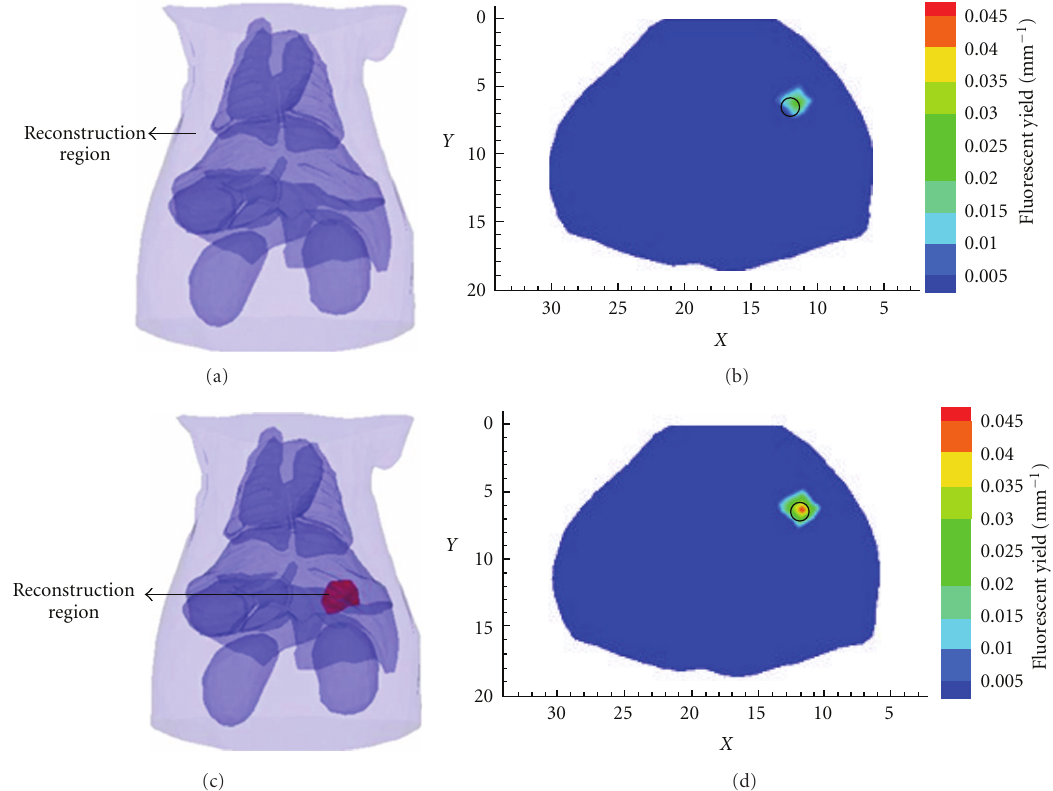
Figure 3: Reconstructed results on the two stages. (a) is the reconstruction region for the first stage, which contains the whole torso section of the mouse. And (b) is the coronal view of the recovered result for the first stage. The red region in (c) is the reconstruction region for the second stage. And (d) is the corresponding coronal view of reconstruction result.